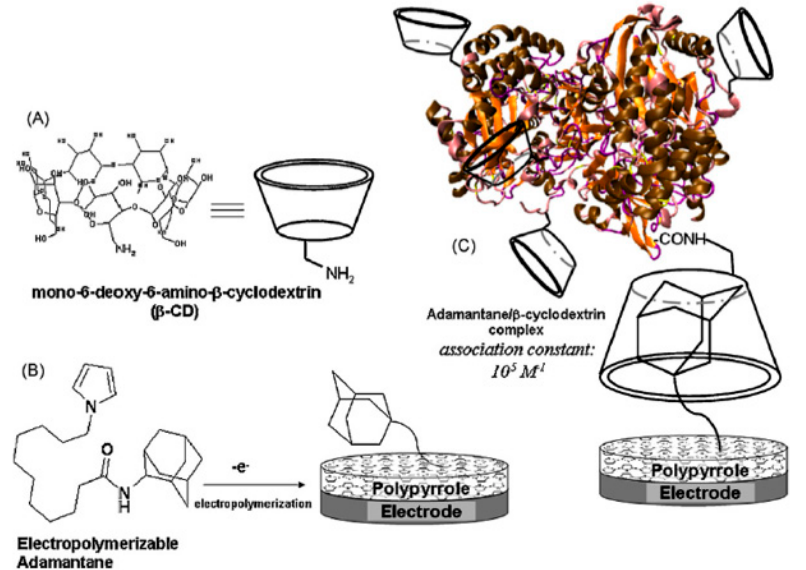
Figure 9. ( A ) Schematic of β -CD; ( B ) Electrogeneration of poly(adamantane-pyrrole) on the electrode surface; ( C ) β -CD-tagged GO x and adamantane-modified electrodes [98].